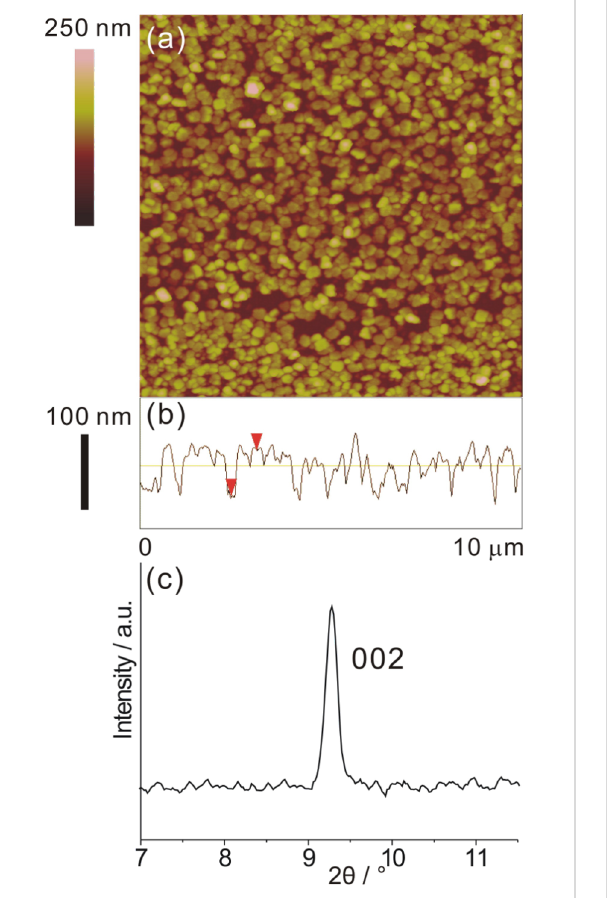
Figure 5: [Zn 2 (adc) 2 (dabco)] grown on a PPP1 surface at 60 °C after 45 cycles. (a) AFM image; (b) cross-sectional profile; (c) SXRD pattern of the range in which the (110) and the (002) reflections are expected.